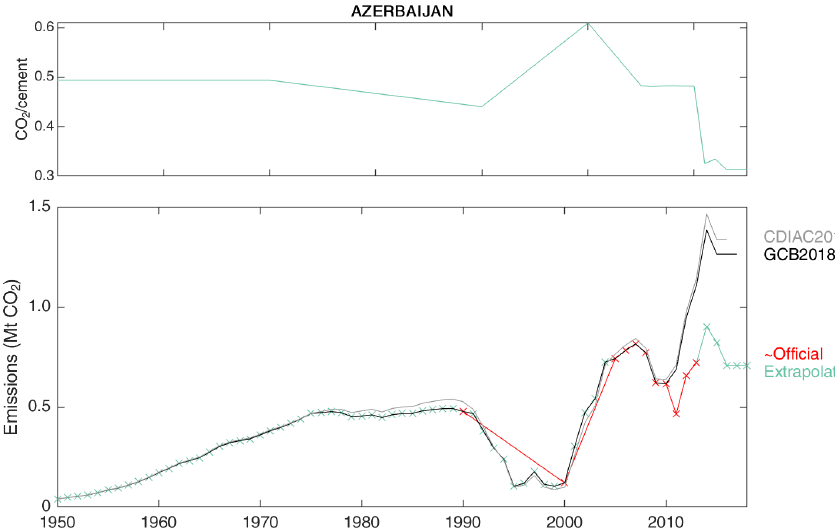
Figure C11. Revised cement emissions for Azerbaijan.